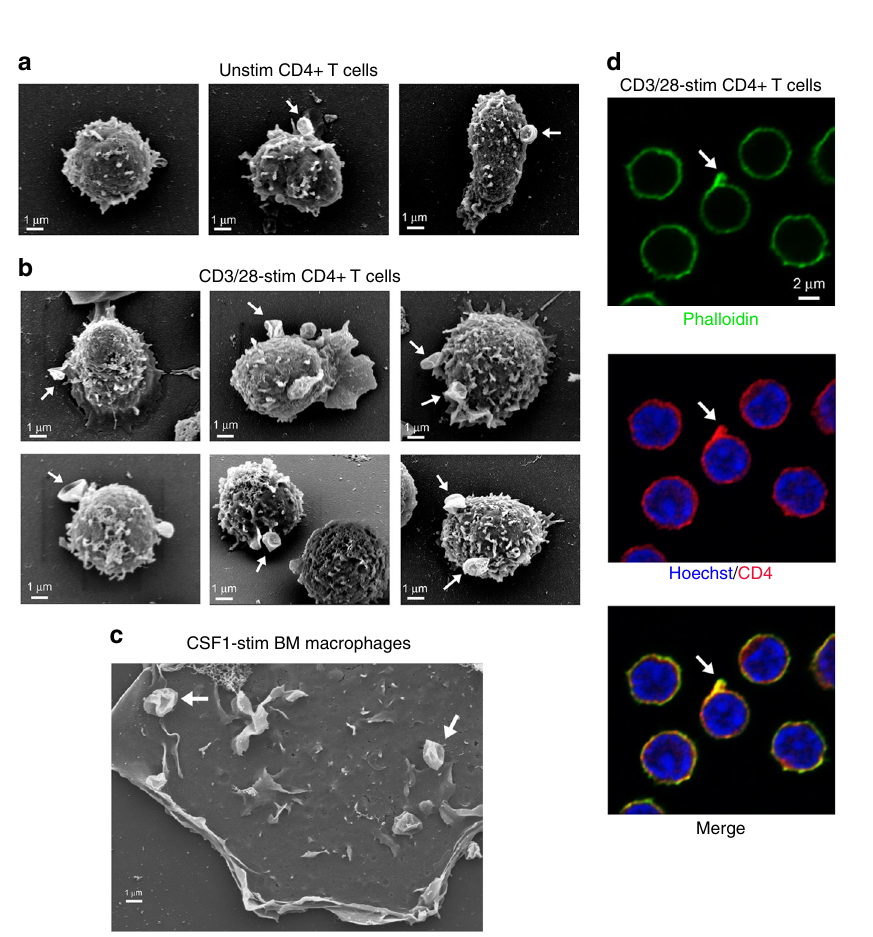
Fig. 2 T cell macropinocytosis. a , b SEM images of murine CD4 + T cells, unstimulated or stimulated with CD3/28 mAb for 16 h. Macropinocytic cups at different stages of development are indicated (arrows). c SEM image of a murine BM macrophage stimulated with CSF1 for 15 min. Note similarity of macropinocytic cups to those identi fi ed in T cells (arrows). d Murine CD4 + T cells, stimulated with CD3/28 mAb for 16 h, were fi xed and permeabilized, stained with Alexa 488-labeled phalloidin and anti-CD4 mAb, and analyzed by confocal microscopy. Shown images are 3 μ m above the plane of T cell contact with the substratum. Note cell surface projected loop of polymerized actin